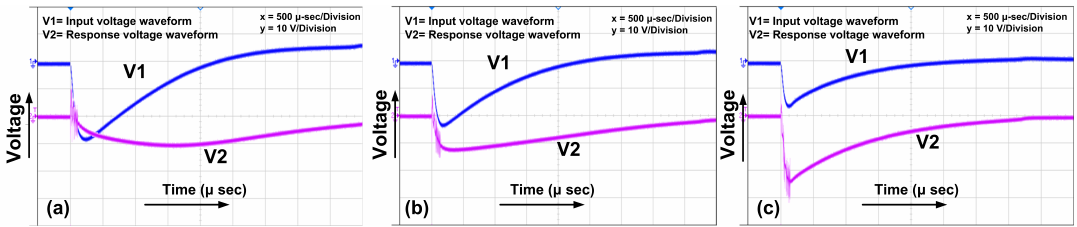
Figure 5. Comparison of the input and response voltage waveforms for the inter-turn short diagnosis: ( a ) Normal case ( b ) Sh-1 ( c )